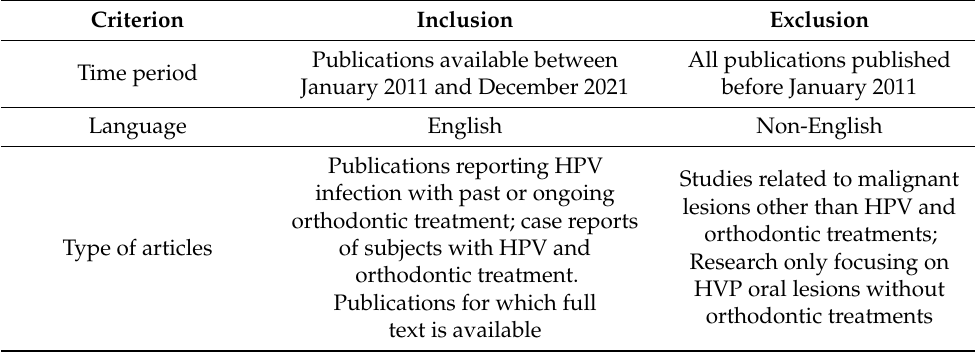
Table 1. Inclusion and exclusion criteria.